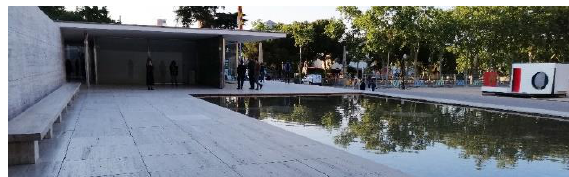
Figure 14. Tiny Bauhuas Pavilion, Barcelona / Spain (Photo by the